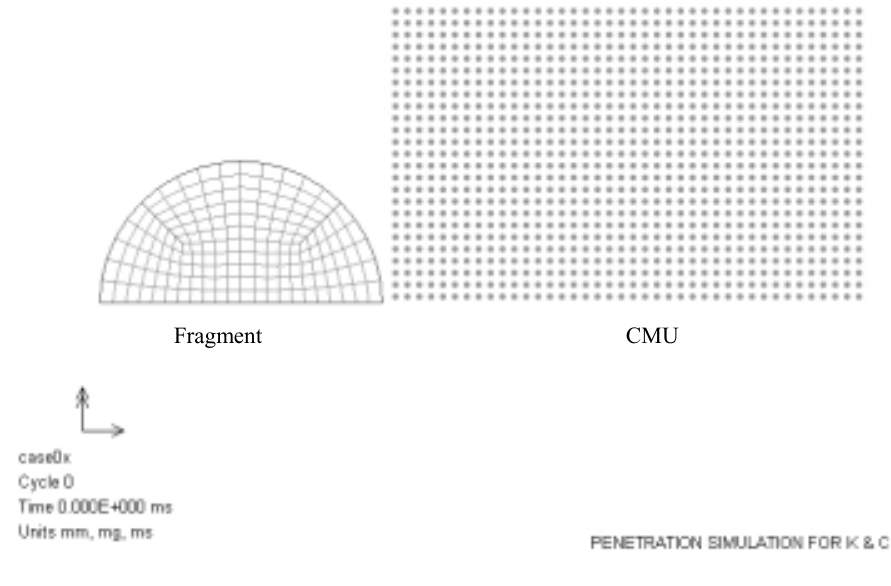
Fig. 3. Close-up view of mesh representing fragment and